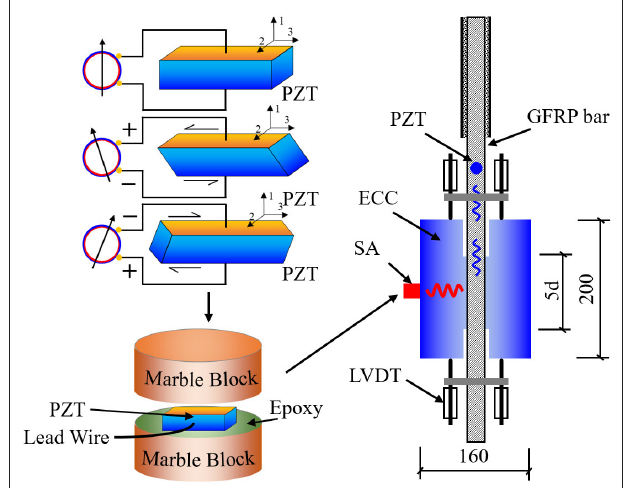
FIGURE 1 | Detection principle and dimensions of specimens.